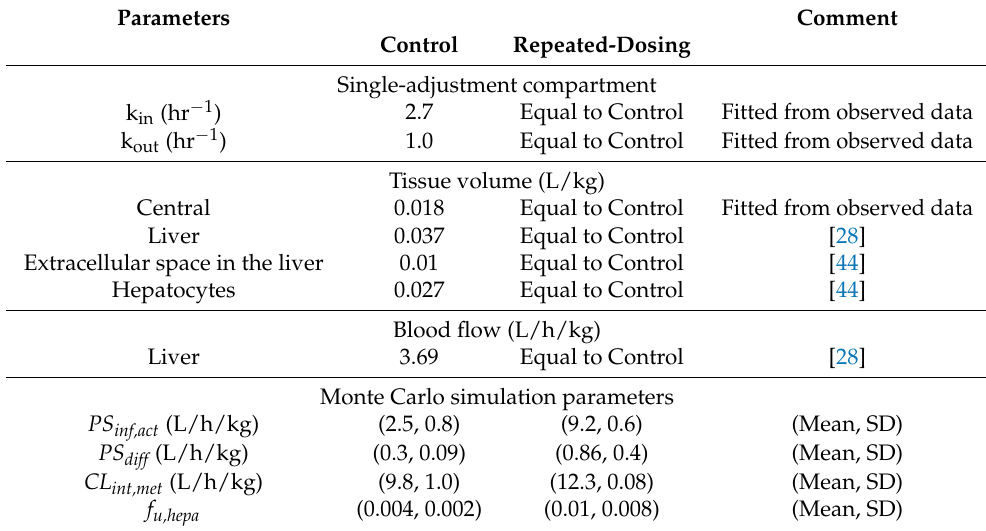
Figure 7. Schematic diagram of the mPBPK model with a single-adjustment compartment was designed to predict the plasma and liver concentrations in the control and repeated-dosing groups. The liver unit was composed of five units to mimic the dispersion model. The dotted, dashed line between the inlet and liver units is the passive diffusion clearance ( PS diff ), and the solid downward line is the active transporter-mediated uptake ( PS inf,act ) clearance. The solid downward line at the bottom of the liver units is the metabolic clearance ( CL int,met ). Table 3. Input parameter values used for the mPBPK modeling and Monte Carlo simulation.